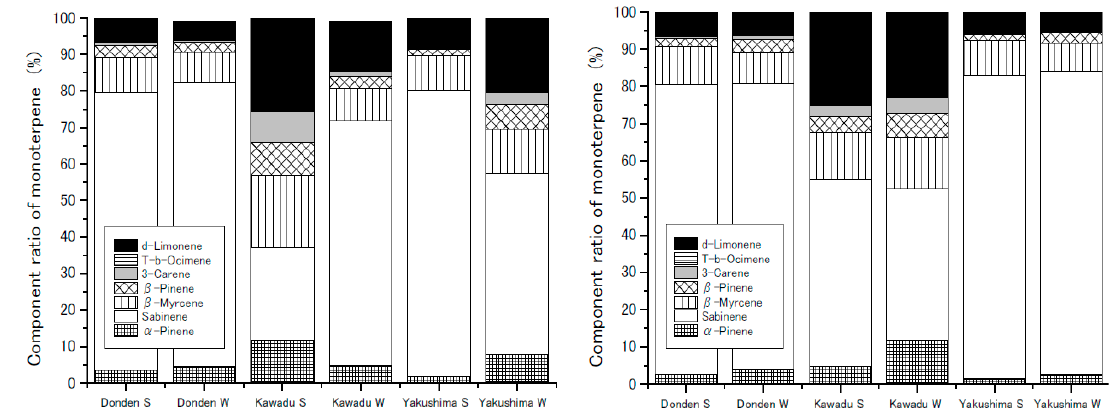
Figure 6. Weighted average comparison of monoterpenes between summer and winter for the control group ( left ) and ozone exposure group ( right ). S: summer; W: winter.